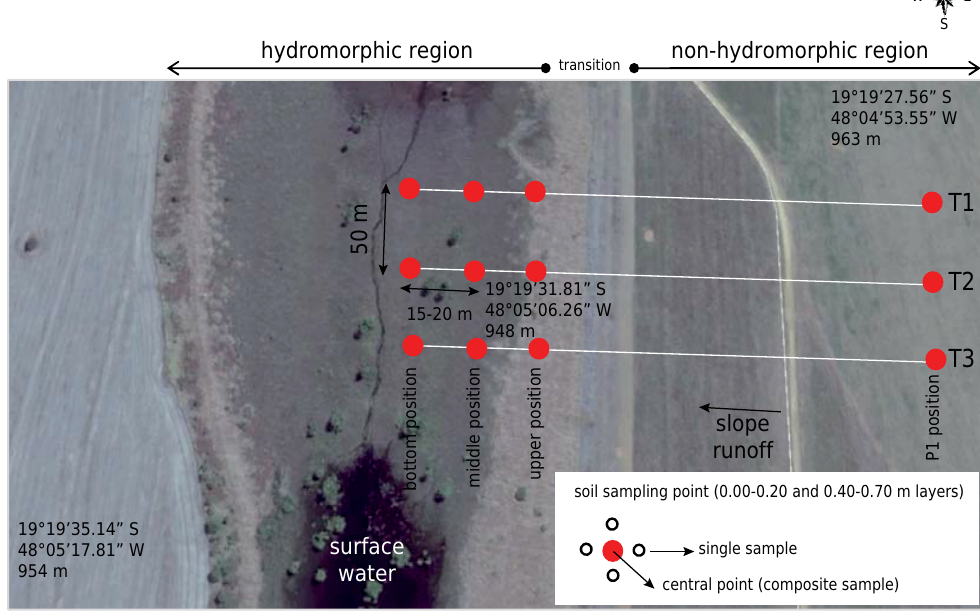
Figure 2. Details of soil sampling scheme. The background image was obtained from Google Earth and it corresponds to the W1 wetland